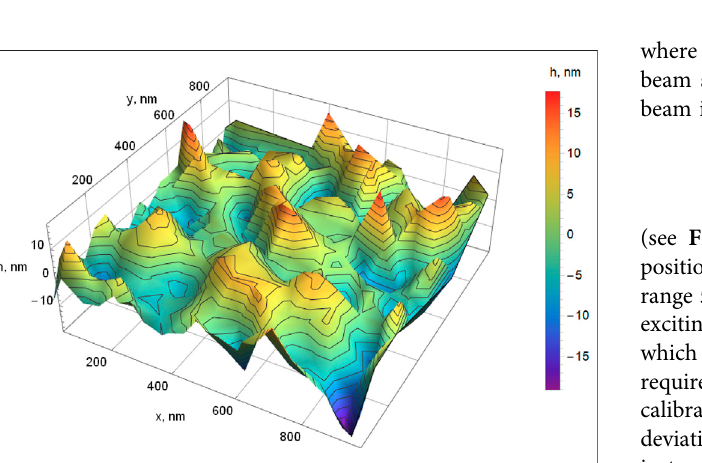
FIGURE7| Diagramillustratingtheresultsofthesurfaceinhomogeneityreconstruction.Insetshowsnumericalvaluesofheightsinnanometersforthepointsofthe selected area 0.2 × 0.2 μ m 2 (cf. Figure 6 ) with respect to the base surface plane.